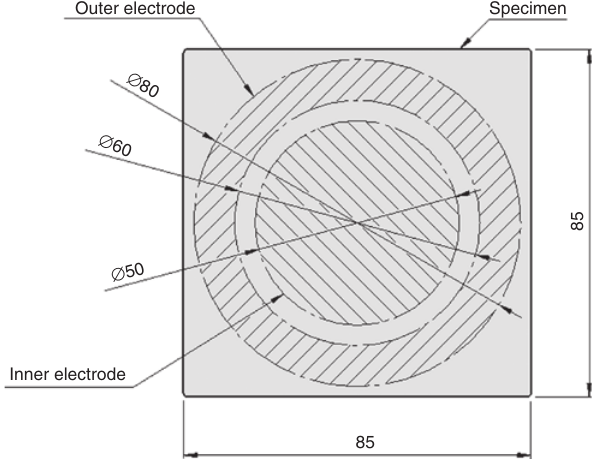
Figure 4 Electrode dimensions and their locations on specimen during test.